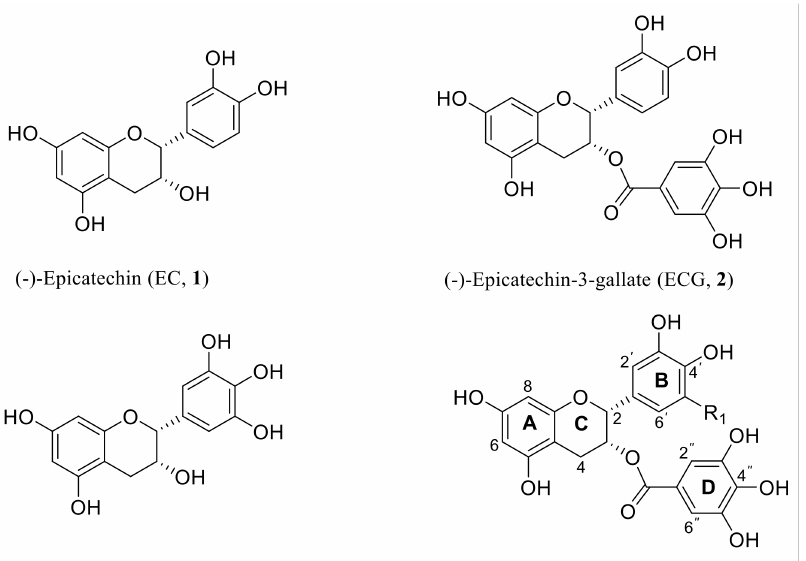
Figure 1. Structures of (-)-epicatechin (EC, 1 ), (-)-epicatechin-3-gallate (ECG, 2 ), (-)-epigallocatechin (EGC, 3 ), and (-)-epigallocatechin-3-gallate (EGCG, 4